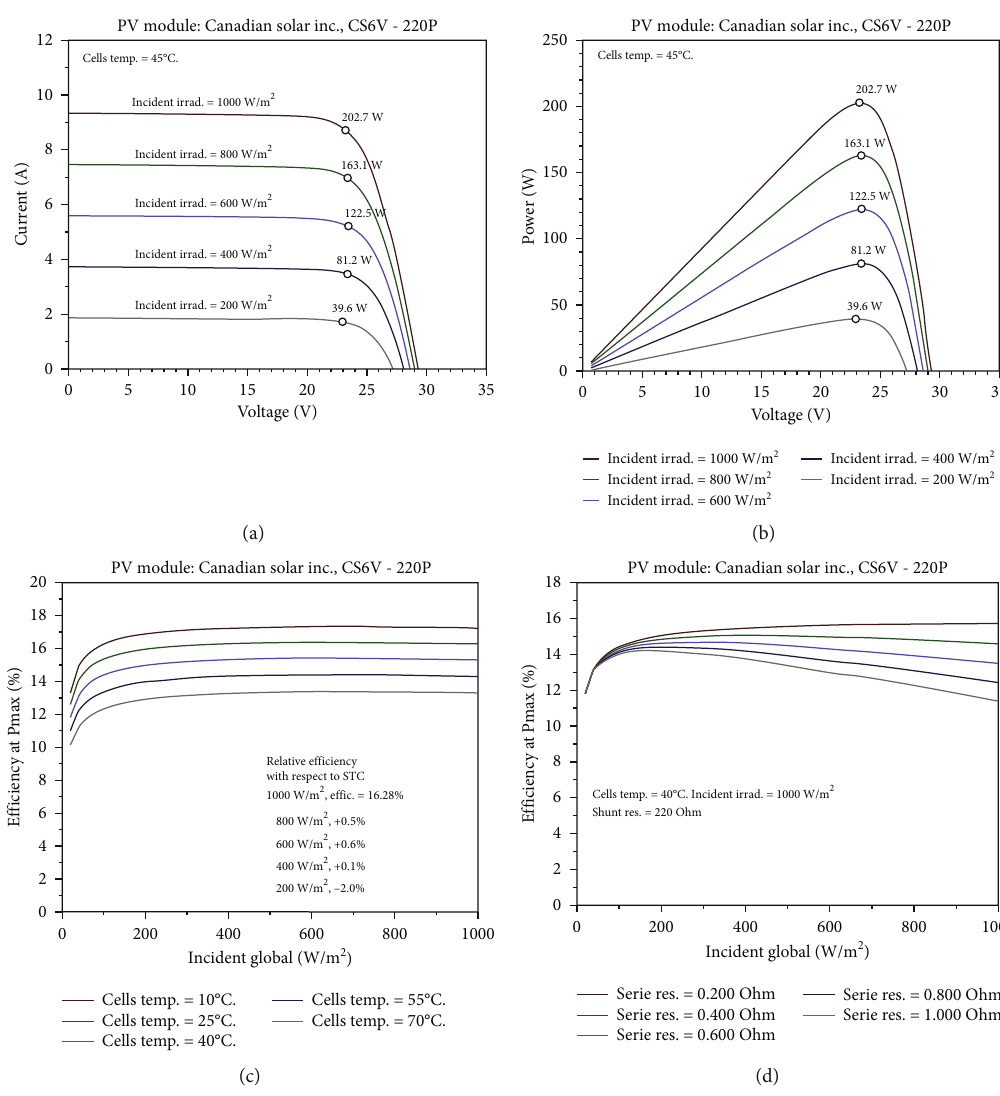
Figure 6: Technical characteristics of PV panels. Variations of the (a) current as a function of the voltage; (b) power as a function of the voltage; (c) e ffi ciency with the global incident for di ff erent cell temperatures; (d) e ffi ciency with the global incident for various series